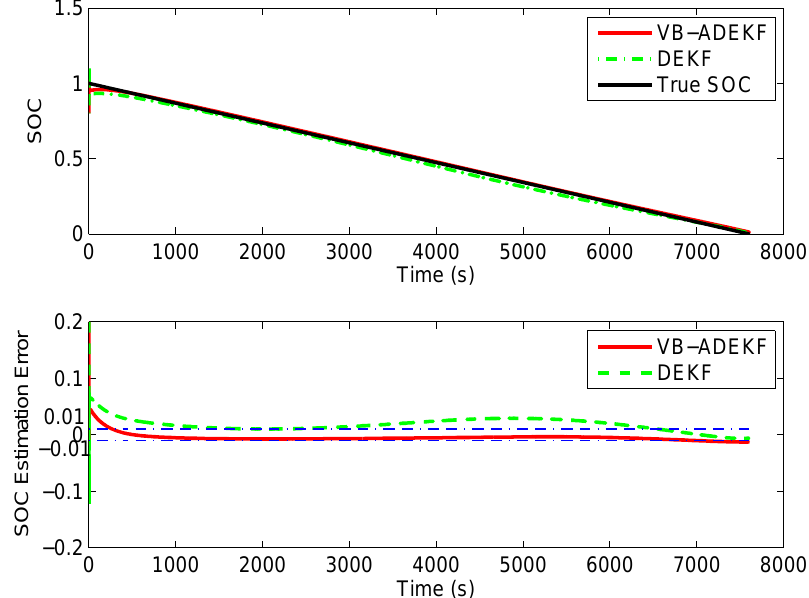
Figure 17. SOC estimation results using VB-ADEKF and DEKF in the case of mistuning in the constant current discharge